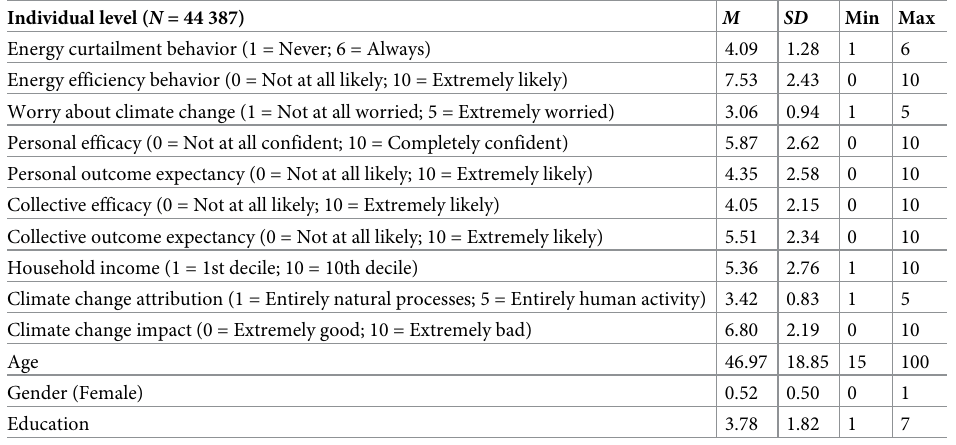
Table 1. Descriptive statistics for the variables in the study. Individual level ( N = 44 387) M SD Min Max Energy curtailment behavior (1 = Never; 6 = Always) 4.09 1.28 1 6 Energy efficiency behavior (0 = Not at all likely; 10 = Extremely likely) 7.53 2.43 0 10 Worry about climate change (1 = Not at all worried; 5 = Extremely worried) 3.06 0.94 1 5 Personal efficacy (0 = Not at all confident; 10 = Completely confident) 5.87 2.62 0 10 Personal outcome expectancy (0 = Not at all likely; 10 = Extremely likely) 4.35 2.58 0 10 Collective efficacy (0 = Not at all likely; 10 = Extremely likely) 4.05 2.15 0 10 Collective outcome expectancy (0 = Not at all likely; 10 = Extremely likely) 5.51 2.34 0 10 Household income (1 = 1st decile; 10 = 10th decile) 5.36 2.76 1 10 Climate change attribution (1 = Entirely natural processes; 5 = Entirely human activity) 3.42 0.83 1 5 Climate change impact (0 = Extremely good; 10 = Extremely bad) 6.80 2.19 0 10 Age 46.97 18.85 15 100 Gender (Female) 0.52 0.50 0 1 Education 3.78 1.82 1 7 Note . All variables are weighted with a combination of post-stratification weights and population weights. The variables are presented in their original scales, except that climate change impact has been